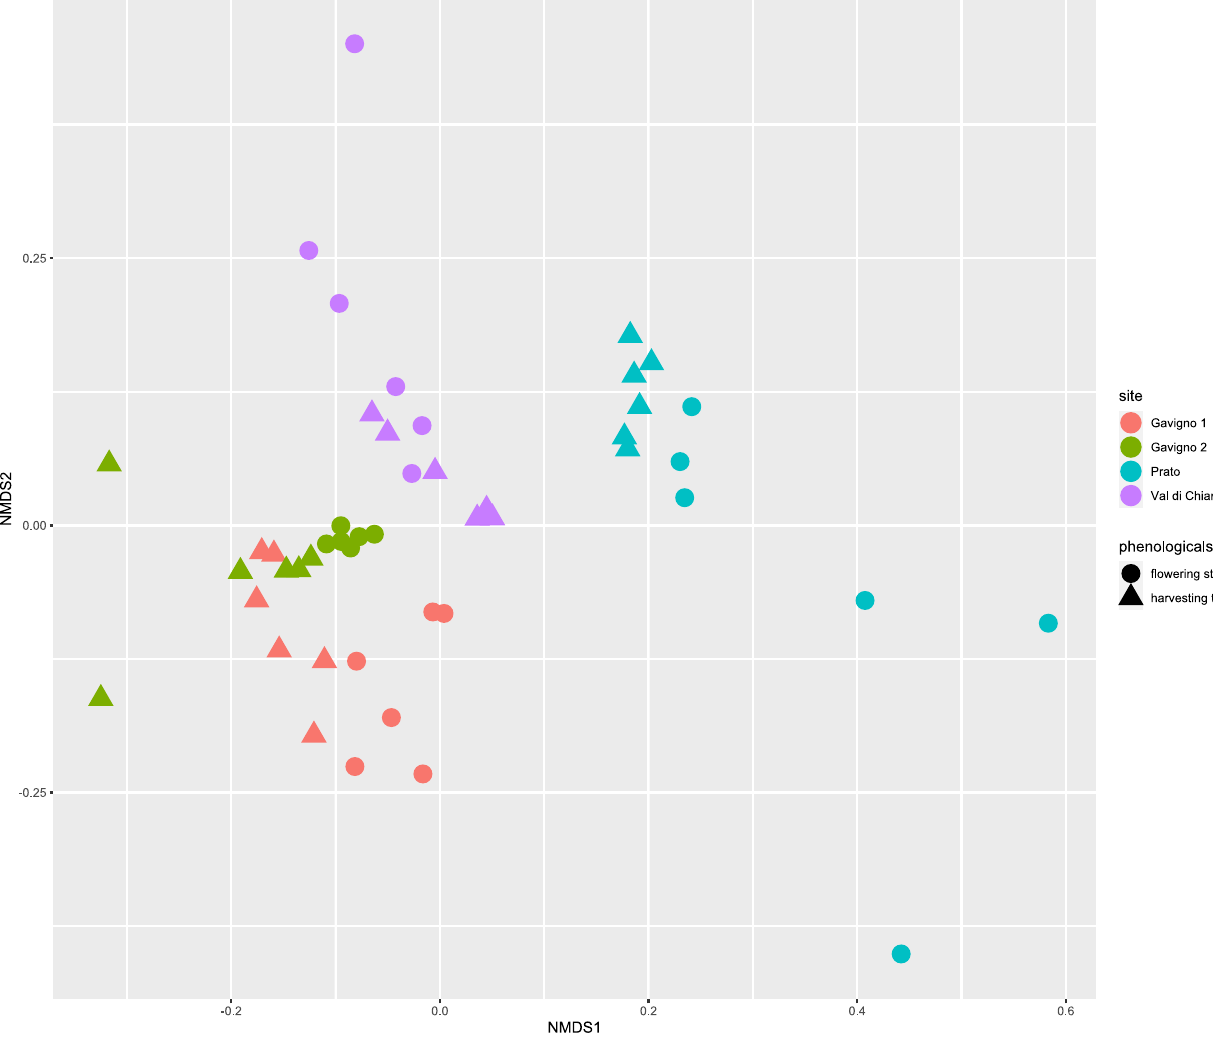
Figure 3. Nonmetric multidimensional scaling of potato bacterial rhizomicrobiota. Colors indicate locations; circles, flowering stages; triangles, harvesting stages. Stress value = 0.17.